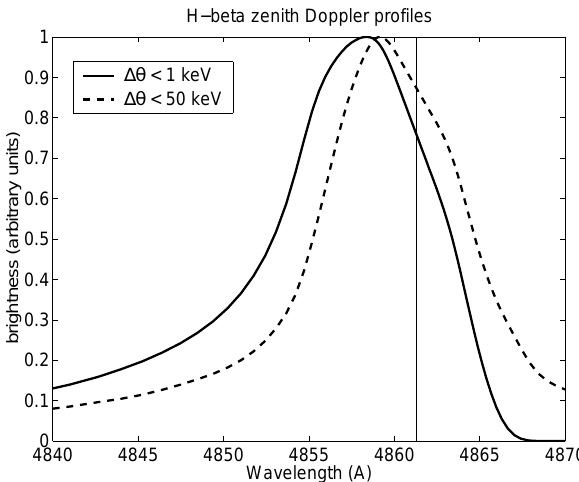
Fig. 15. Fitted profiles for four dif- ferent times showing changes in the fitted peak and halfwidth of the blue wing. The intensity scale is in counts per minute.